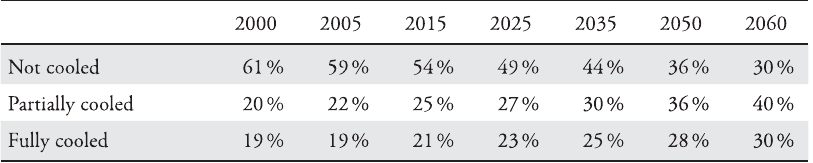
Table 2: Cooled Surfaces Expressed as Percentagea ofTotal Surfaces in the Service Sector under a Scenario with no Climate Change (Source: AEBISCHER et al., 2007) 2000 2005 2015 2025 2035 2050 2060 Not cooled 61% 59% 54% 49% 44% 36% 30% Partially cooled 20% 22% 25% 27% 30% 36% 40% Fully